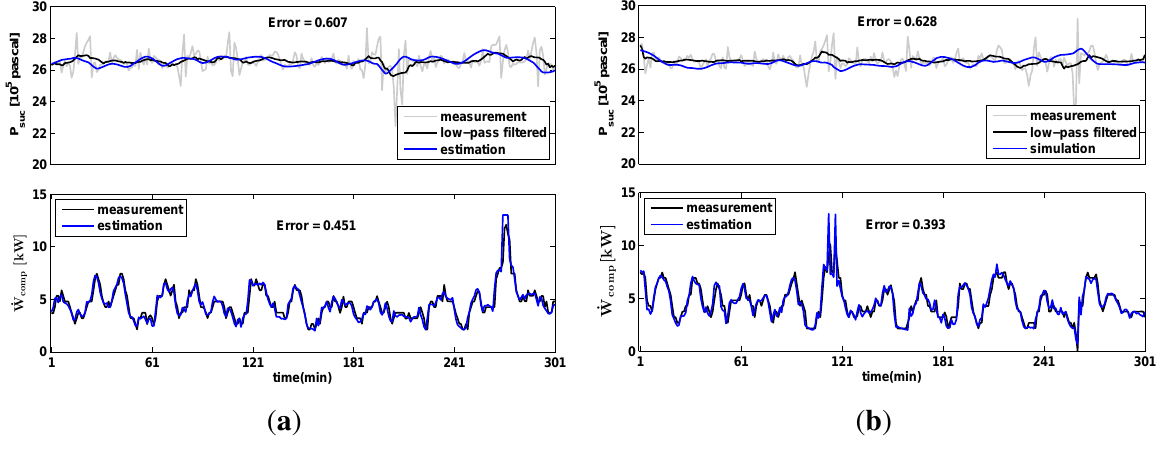
= 0 . 65 . ( a ) Estimation using me